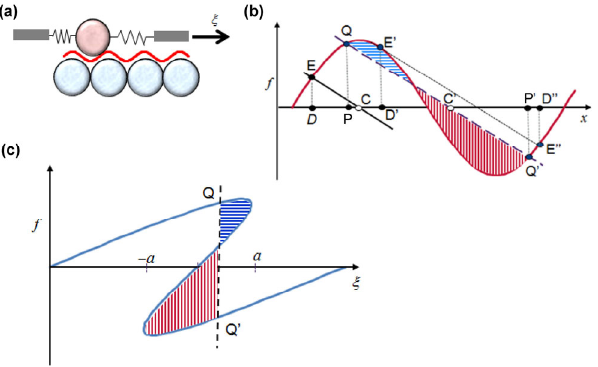
Fig. 2 (a) Basis of Prandtl model of an elastically constrained atom sliding over a plane of atoms; (b) force plotted against stationary surface coordinate showing instability at D’; (c) force plotted against slider